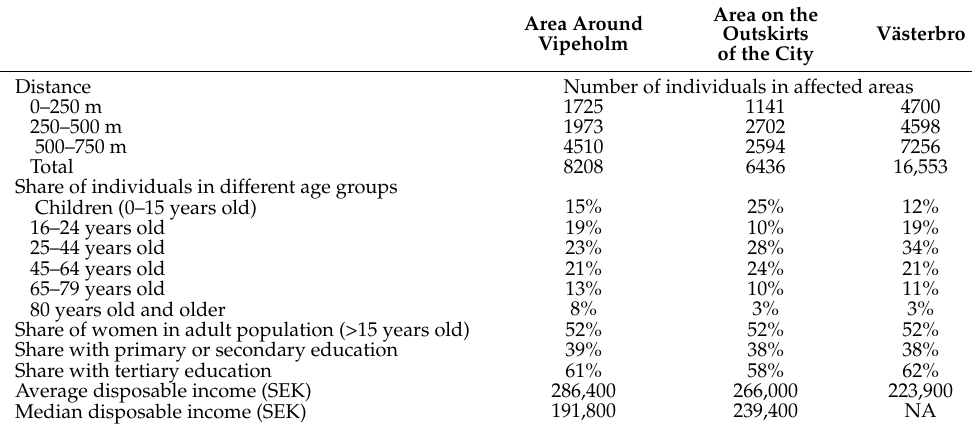
Table 3. Number of individuals and characteristics of individuals in the affected